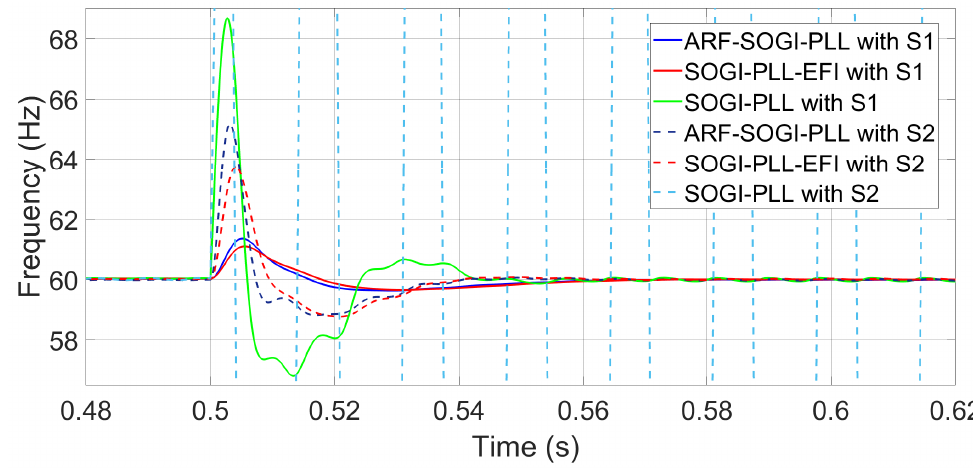
Figure 14. Frequency before, during and after a voltage sag of 80%.